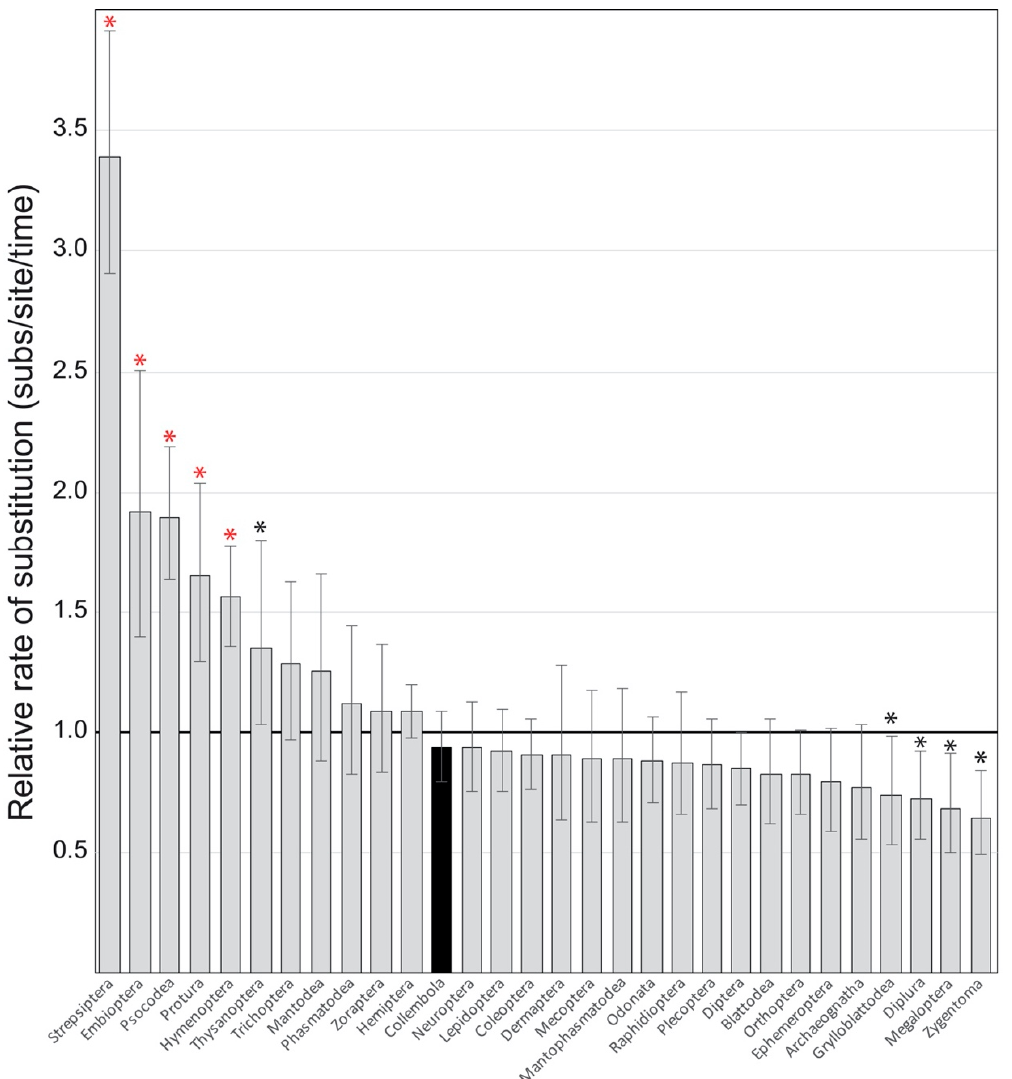
Figure 3. Bar chart of mean relative rates of nucleotide substitution in COI for all major Hexapod groups. Error bars represent the 95% highest posterior density (HPD) mean rate interval. Asterisks indicate rates that are significantly different from the mean rate of 1 (horizontal black line); red asterisks indicate rates that are significantly different from Collembola rates (black bar).